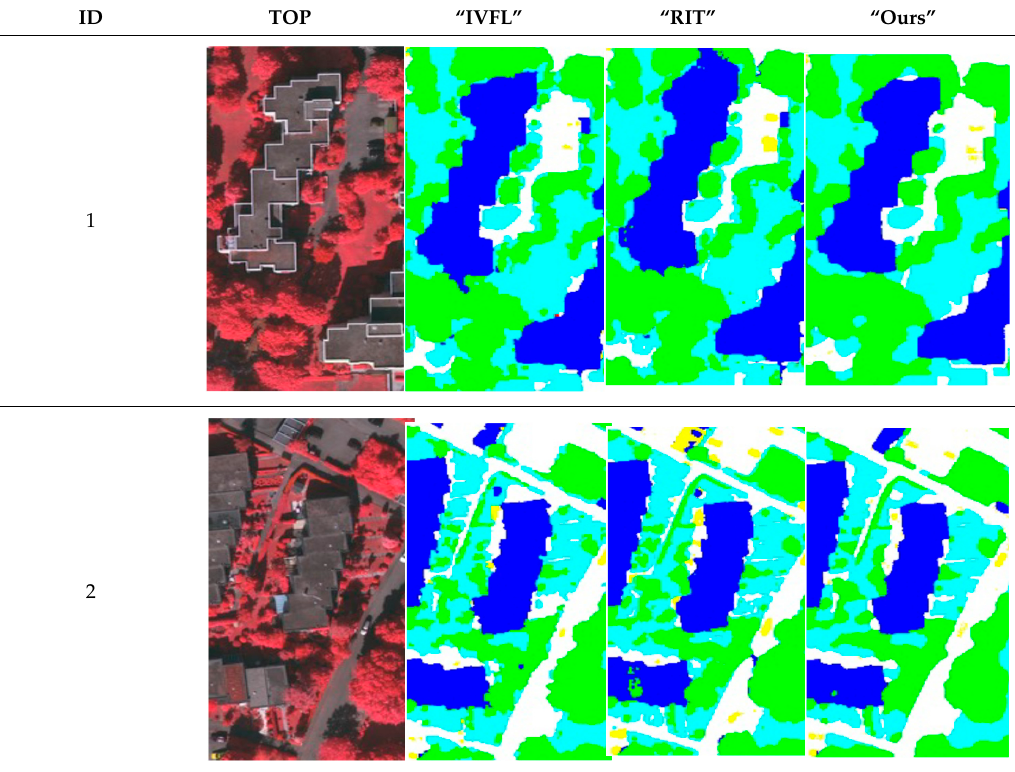
Table 6. Comparing our results with the “IVFL” and “RIT”.